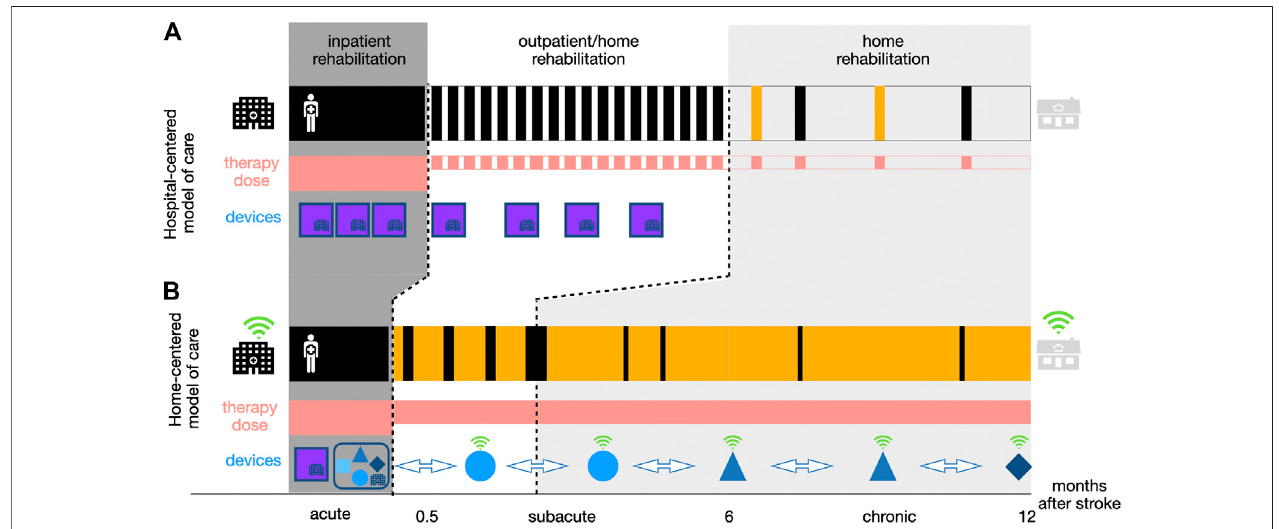
FIGURE 1 | Two approaches to neurorehabilitation along the continuum of care. Compared to the hospital-centered model of stroke rehabilitation (a), the home-centered modelofcare(b)aimstoreducethetimeapatient spendsin ahealthcareinstitution (depicted in black)physicallyvisitingarehabilitation professional. However, patientsreceivea similar or even potentially higher dose of therapy (depicted in red) due to continued self-directed training at home (depicted in yellow). This should be supported by different complementary mobile technology-based devices (e.g., robotics, wearables, virtual reality games) (blue shapes) introduced early in the inpatient rehabilitation (i.e., RehabGym), and that can, after a familiarization phase under therapist supervision, be taken home by patients to continue with a minimally supervized rehabilitation training (i.e., without the presence of a clinician or expert operator). These devices should be intelligent connected tools (depicted in green, more detail on a possible implementation in Going Beyond COVID-19: Moving Towards Minimally-Supervised Robot-Assisted Therapy ) allowing for remote patient monitoring, whileempowering and motivating patients to engage in high-quality therapy from a distance, which is not possible with traditional stationary neurorehabilitation technologies (purple blocks).